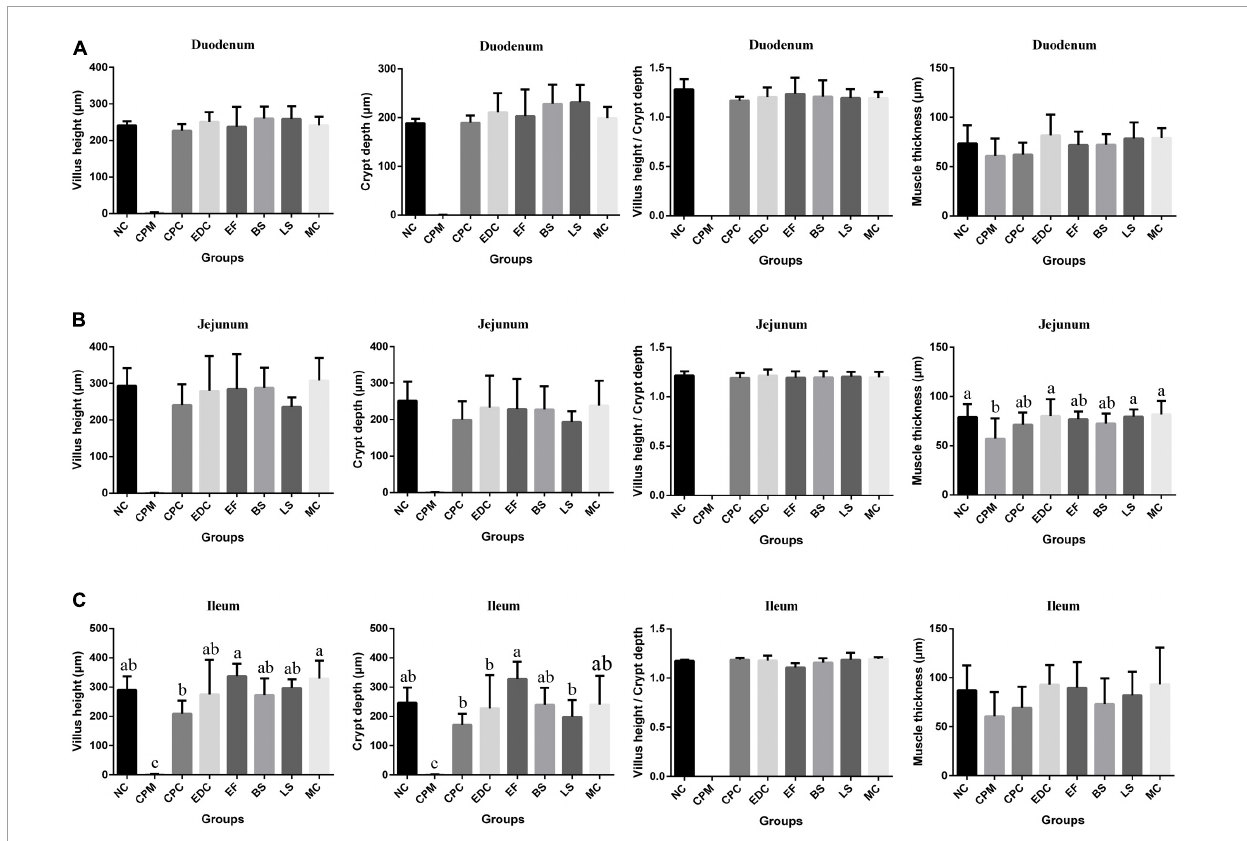
FIGURE3 Morphological changes in the small intestine of mice after different treatments ( n = 6). (A) Duodenum; (B) Jejunum; (C) Ileum. Data represent mean values ± SEM. a-c Means with different superscripts within a row were significantly different ( P < 0.05).